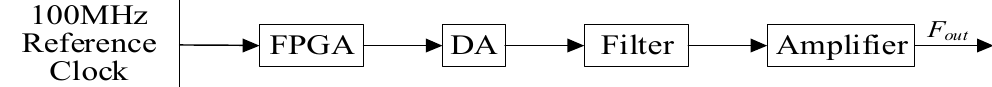
Figure 5. Block diagram of DDS frequency synthesizer based on FPGA.